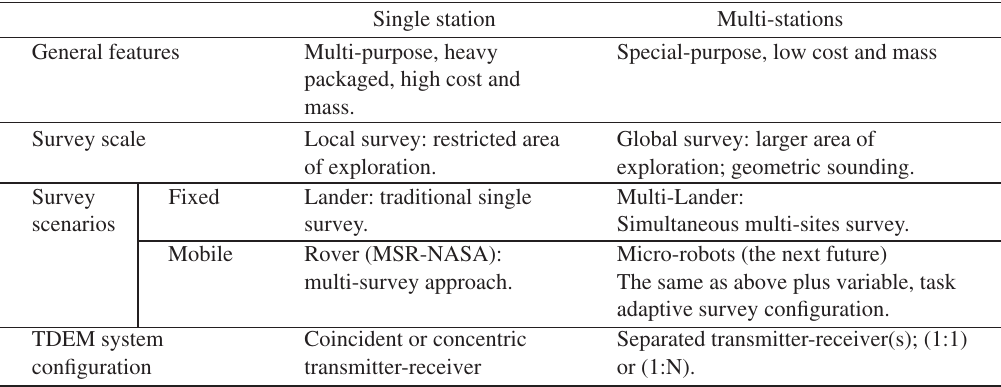
Table I. Mission scenarios for a TDEM survey.